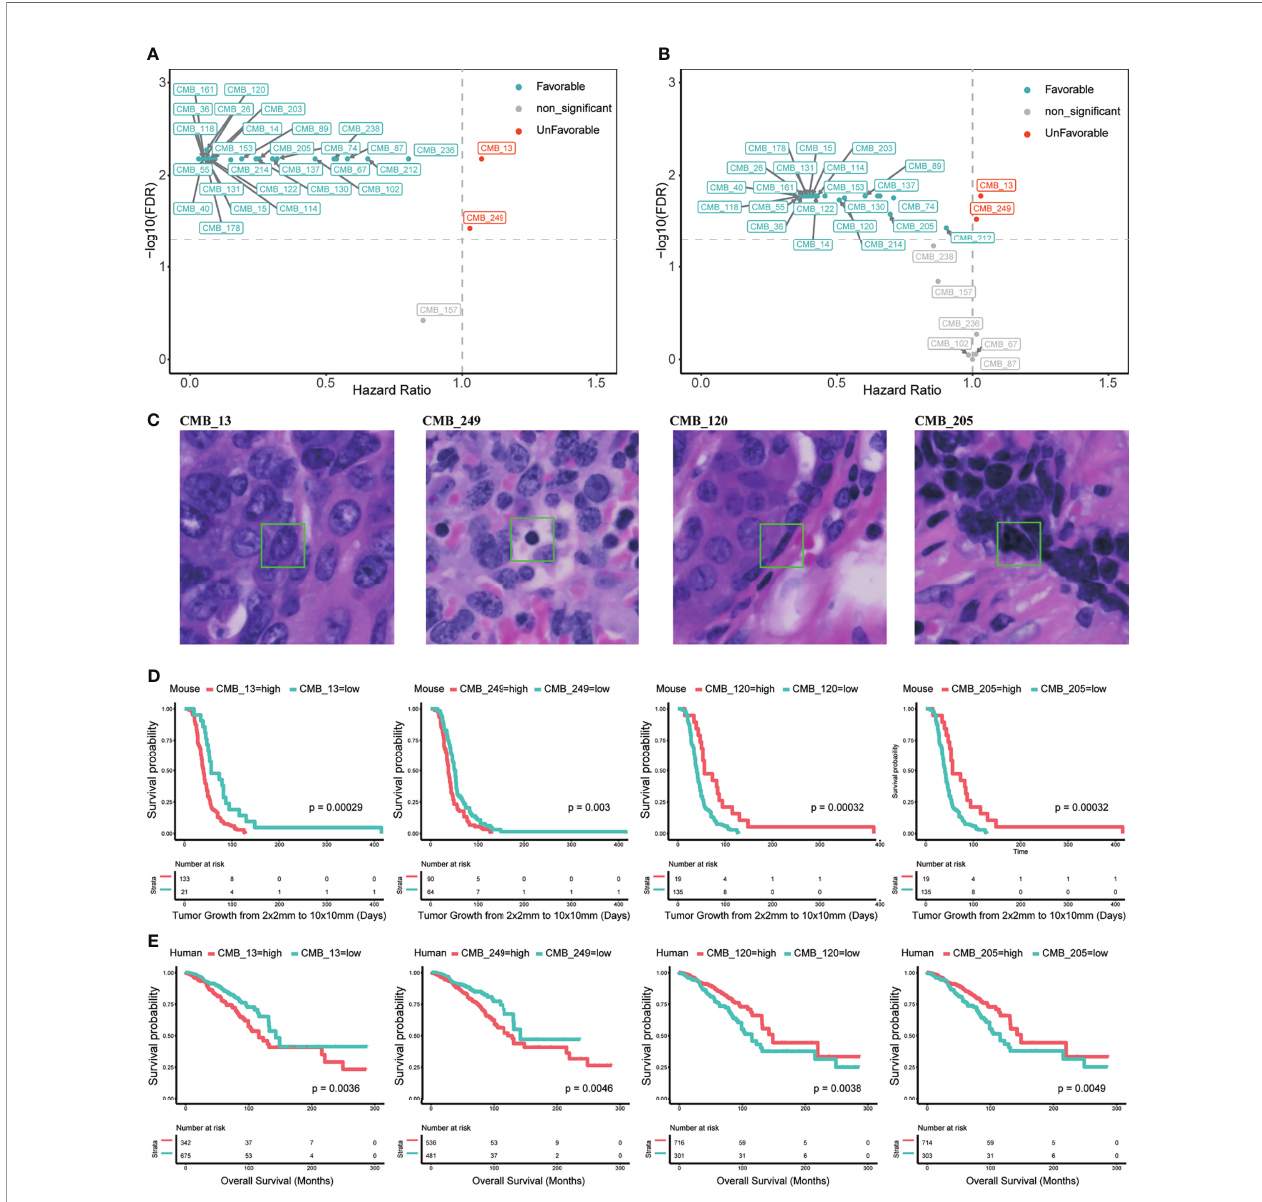
FIGURE 2 | Cellular morphometric biomarkers (CMB) learned from mouse mammary tumors and extracted from human breast tumors. (A) Top 30 CMB learned from the Trp53 -null cohort with most prominent variations; (B) Top 30 CMB extracted from the TCGA-BRCA with most prominent variations; (C) Examples of representative CMB learned from the Trp53 -null cohort. (D, E) KM curves for representative CMB learned from the Trp53 -null cohort, and the TCGA-BRCA cohort,